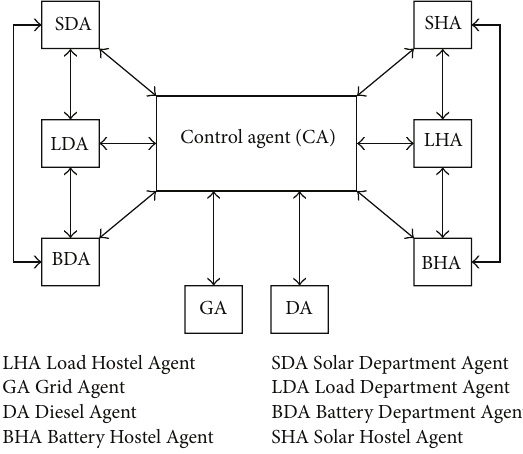
Figure 7: Agents relationship